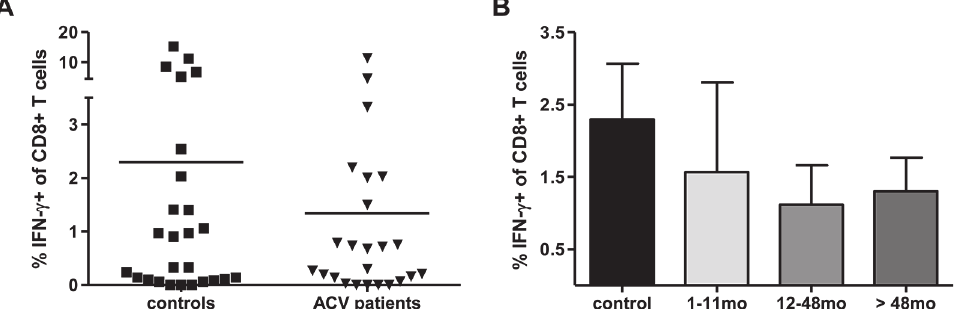
Fig 2. Frequency of IE-1-specific T cells in patients taking acyclovir and in control subjects. (A) Interferon- γ production was measured in response to stimulation of PBMC with IE-1 peptides in controls (n = 26) and ACV-treated donors (n = 24). (B) The frequency of IFN- γ producing cells is shown in relation to the duration of anti-viral treatment. The mean (A) or mean with SEM values (B) are shown on the